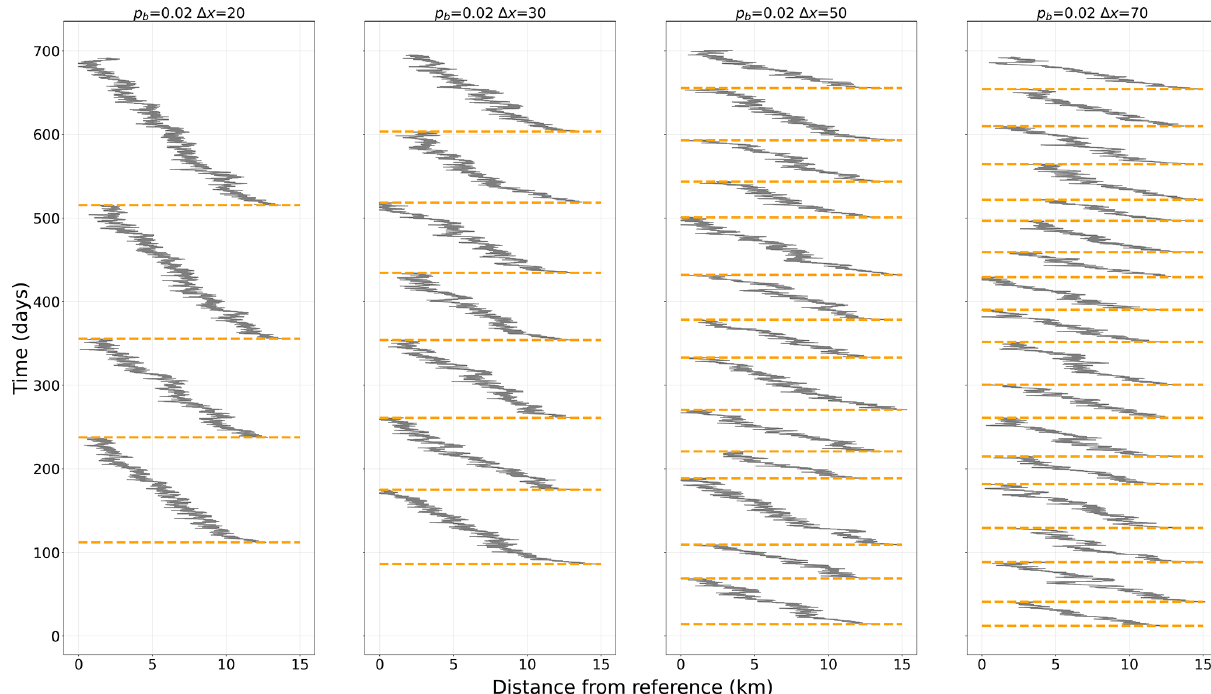
Figure 7. Along-fjord propagation of IMW fronts as modeled by BRIMM. In each panel a different value of maximum random motion (cid:49)x max is used.